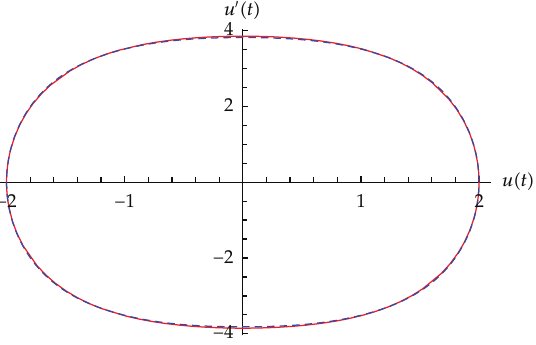
Figure 5: Comparison between the approximate solution (cid:2) 2.34 (cid:3) and numerical results of (cid:2) 2.13 (cid:3) in terms of phase plane in Case b: a (cid:9) b (cid:9) 1 , A (cid:9) 2: dashed red line: numerical solution, dashed blue line approximate